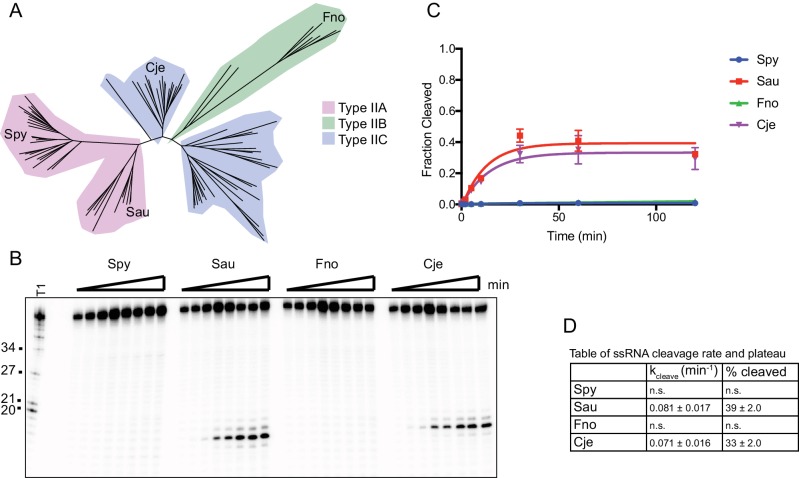
RNA is cleaved by SauCas9 and CjeCas9.(A) Phylogenetic tree of Cas9 homologs assayed for ssRNA cleavage activity. Tree was generated using homologs gathered from (Chylinski et al., 2014). Only homologs tested for activity are highlighted as leaves on the tree. Clades are colored by Cas9 sub-type. (B) Representative in vitro cleavage gel for ssRNA targeting by various Cas9 homologs in (A). Target used for cleavage was the pUC ssRNA. Time points are 0, 1, 2, 5, 10, 30, 60, and 120 min. T1 RNase digest size fragments are given on the left. (C) Quantification of fraction cleaved in (B). Fit was determined in Prism using a single-exponential decay model. Error bars represent the mean ± S.D. (n = 3). (D) Apparent pseudo-first order fit parameters of the data in (C) where ‘% cleaved’ indicates the fraction of substrate cleaved when the reaction plateaus (mean ± S.D.).10.7554/eLife.32724.005Figure 1—figure supplement 1—source data 1.ssRNA cleavage time course for Cas9 homologs.